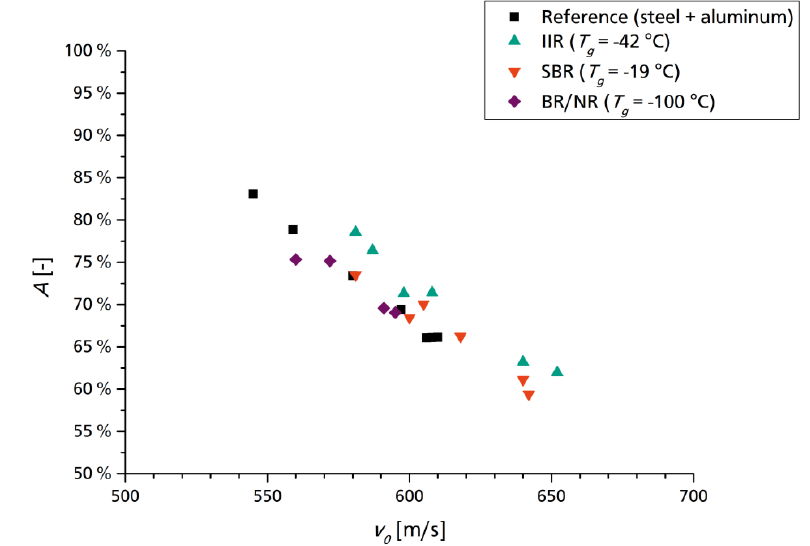
Figure 9. Dependency between absorption parameter A and impact velocity v 0 for different armor configurations.